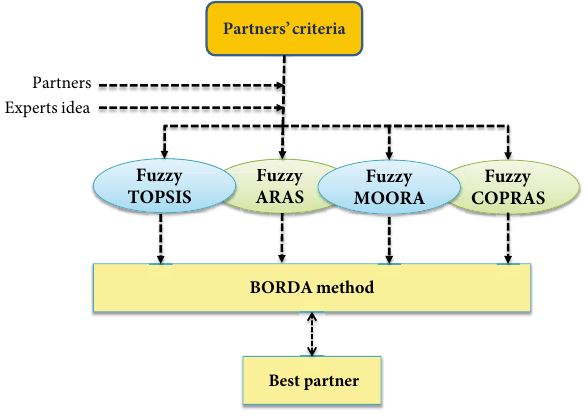
Fig. 3. The second step of the